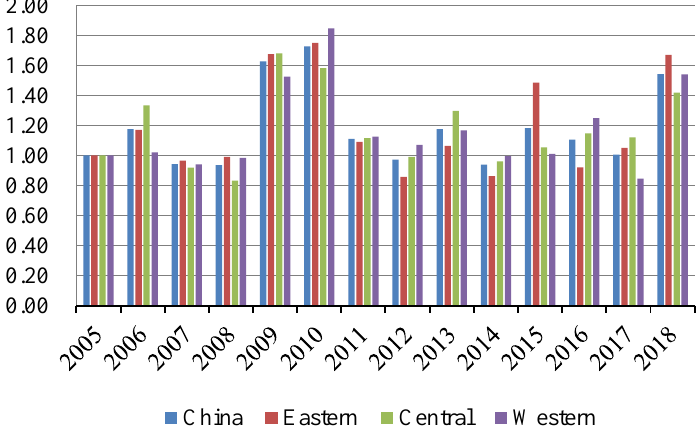
Figure 6. Time trends of technical efficiency (EC).